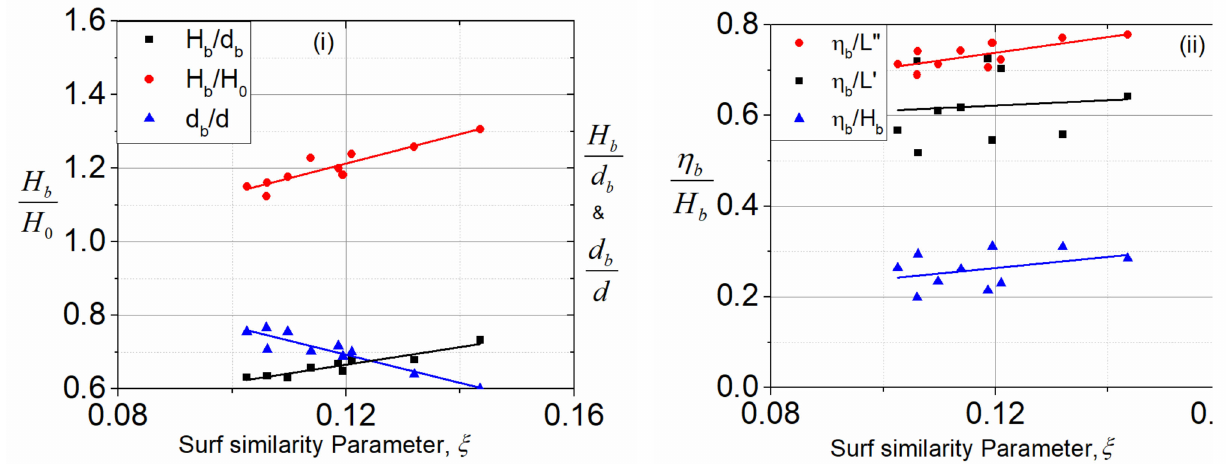
Figure 9. Computed breaking wave parameters vs. surf similarity parameter for varying slope and varying wave steepness ( i ) Relative breaker depth ( d b /d ), breaker depth index ( γ b ) and breaker height index ( Ω b ) vs. surf similarity parameter ( ξ ), ( ii ) wave crest front steepness ( ε ), wave crest rear steepness ( δ ) and horizontal asymmetry factor ( µ ) vs. surf similarity parameter ( ξ